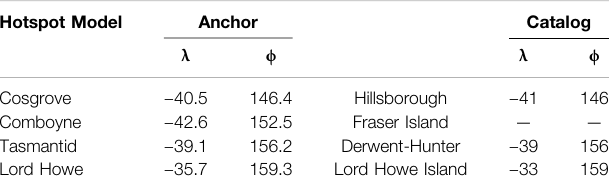
TABLE 1| Estimated present day positionsofeasternAustralianhotspots derived from motion paths (Doubrovine et al., 2012), and from hotspot catalogs (Courtillot et al., 2003; Montelli et al., 2006) (in degrees N and E). λ indicates latitude, ϕ indicates longitude.